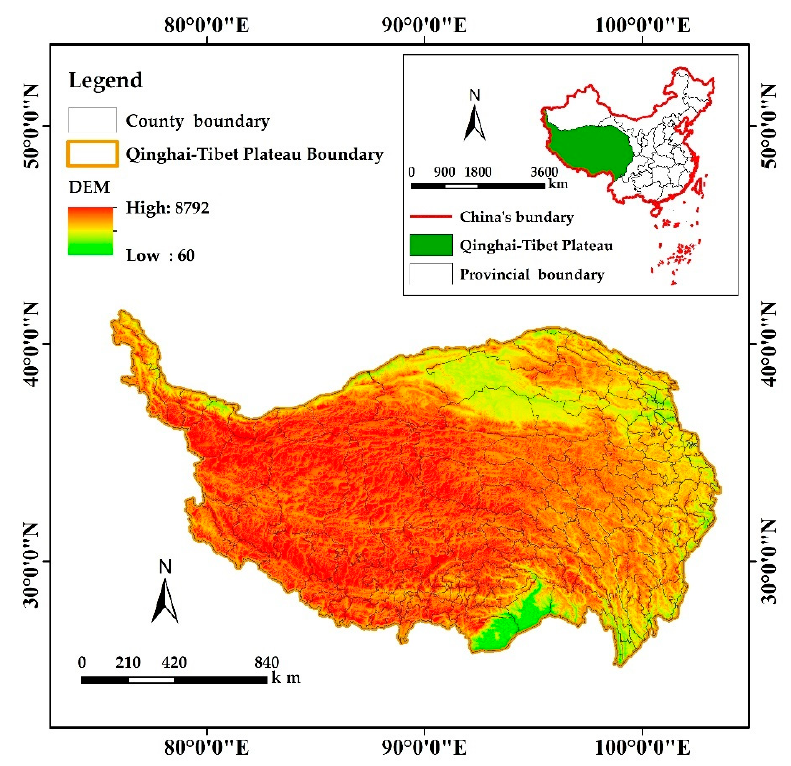
Figure 1. Study Figure 1. Study area.